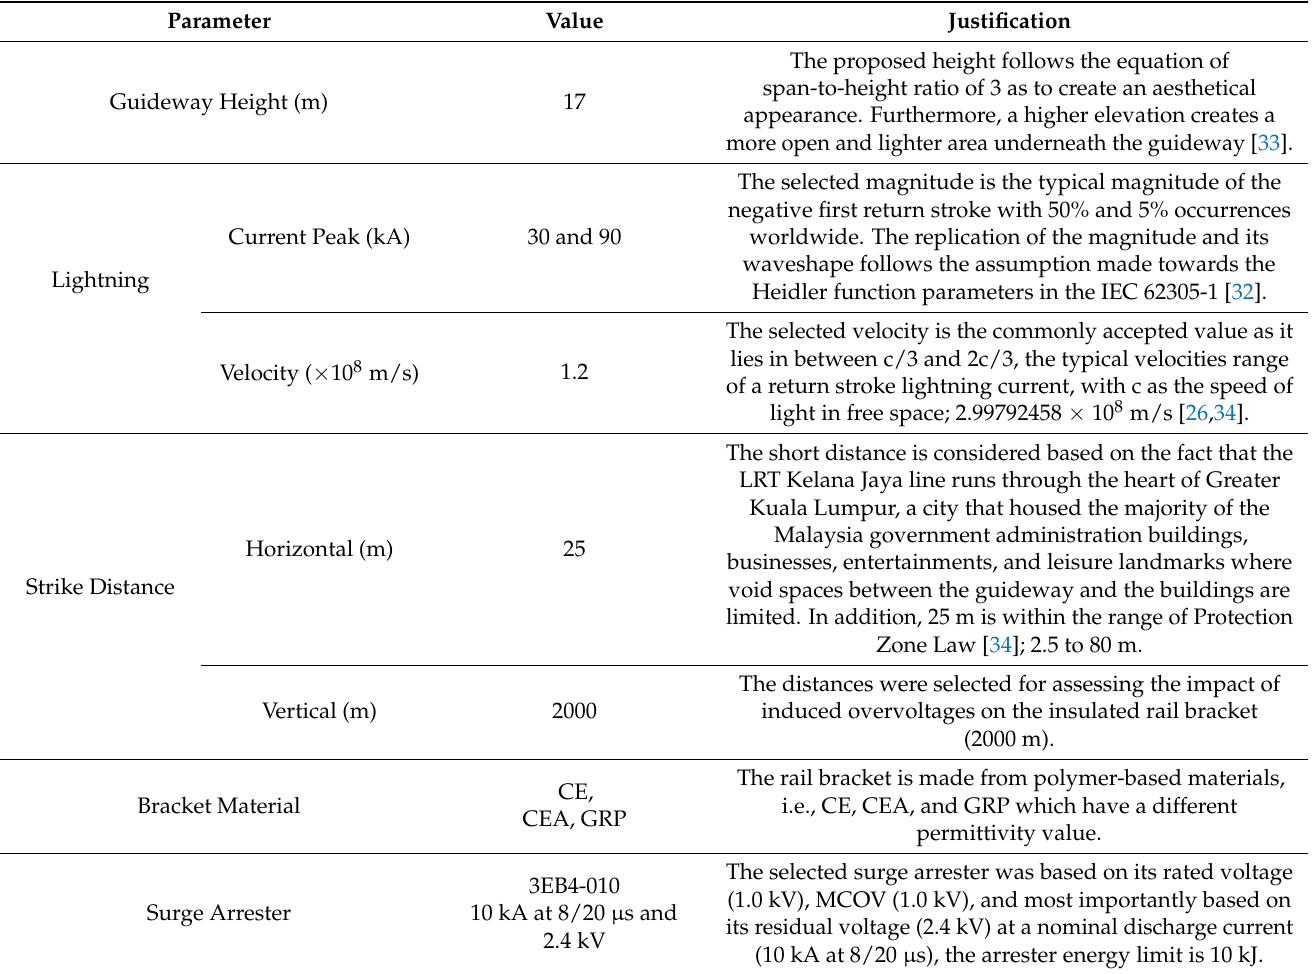
Table 3. Justification of the parameters